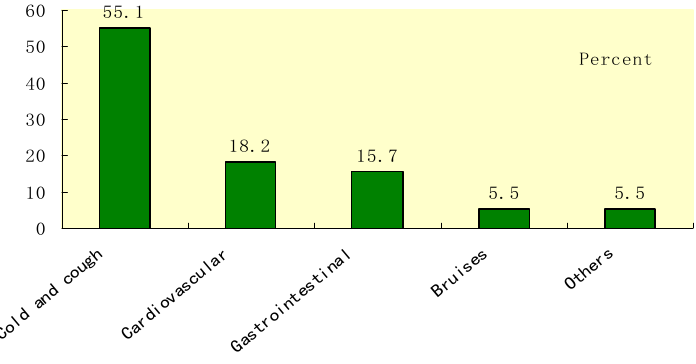
Figure 3. Type of illness for self-medication.